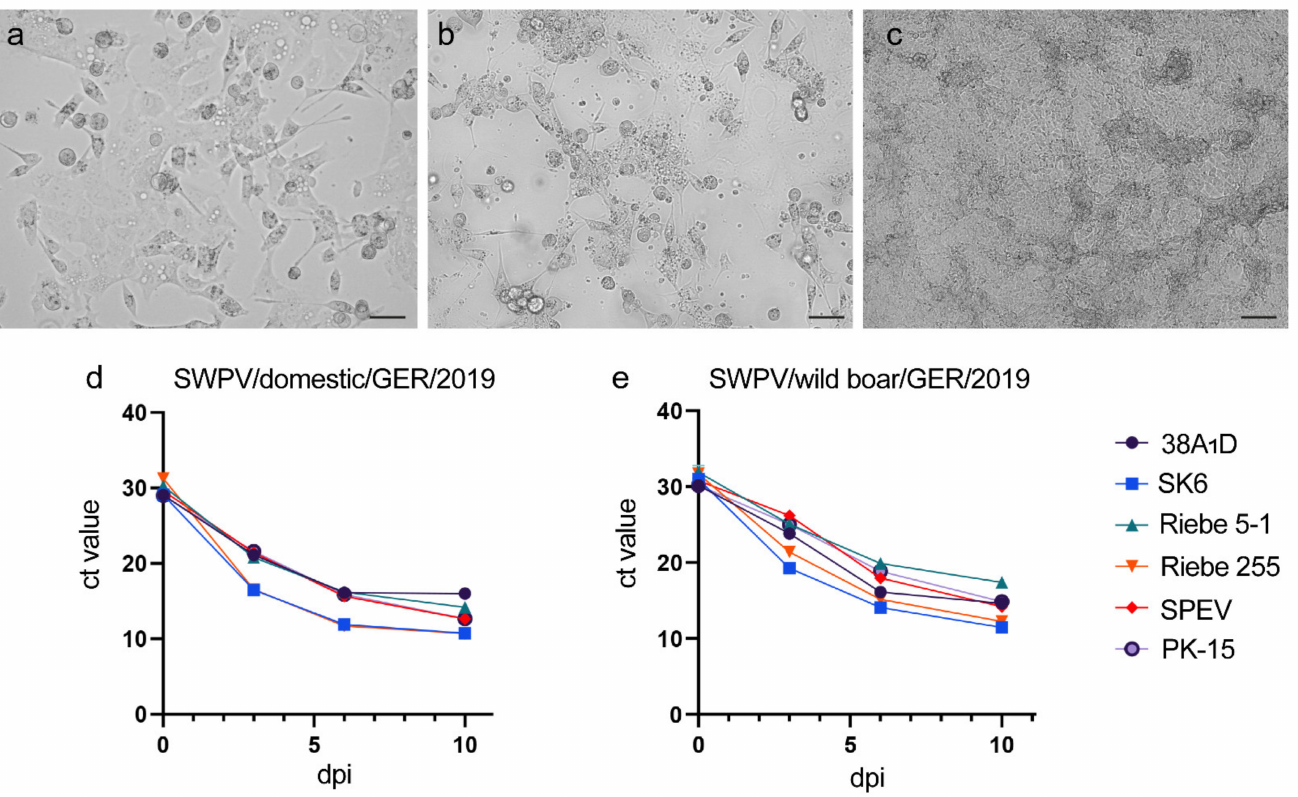
Figure 2. SWPV infection of porcine cell lines. ( a – c ) Characteristic cytopathic effects including cell rounding, ballooning and vacuolization were observed in PK-15 cells infected with a German domestic pig SWPV strain (SWPV/domestic/GER/2019) ( a ) and German wild boar SWPV strain (SWPV/wildboar/GER/2019) ( b ), but not in mock-infected PK-15 cells ( c ). Scale bars, ( a , b ) 30 µ m, ( c ) 75 µ m. ( d , e ) Porcine kidney cell lines (SPEV, SK6 and two PK-15 subclones), porcine testis epithelia cells (Riebe-255) and a porcine lymphoma cell line (38A 1 D) were infected with SWPV/domestic/GER/2019 ( d ) and SWPV/wildboar/GER/2019 ( e ). Supernatants were collected at three, six and ten days post-infection and ct values were determined in triplicate by